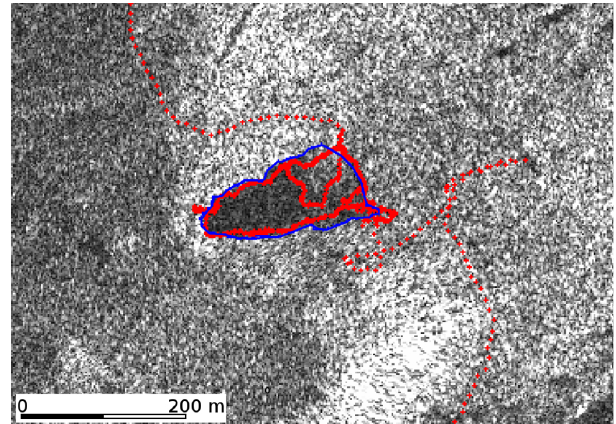
Fig. 4. Terrain-corrected geocoded TerraSAR-X image of 29 July 2009 around the Weingarten Lake in Switzerland. The GPS path to and around the Weingarten Lake acquired during the field visit is overlaid in red. The outline of the lake, determined in the SAR intensity image, is shown in